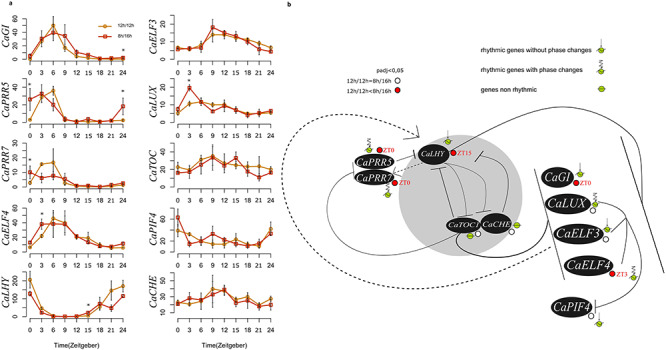
Photoperiod-dependent changes in the expression of core clock genes in 8 h/16 h and 12 h/12 h photoperiods. (a) Photoperiod responses of selected core clock genes. Orange line = 12 h/12 h, red line = 8 h/16 h. ZT0 is equivalent to ZT24. Overall, the patterns of expression observed are identical to those observed in Arabidopsis. Asterisks represent the significant differences of expression occurring between the two photoperiods. P-value was adjusted (Benjamini–Hochberg) and significance considered at a threshold of 0.05. Error bars are means ± SEM of three experimental replicates. (b) Expression of the circadian core clock genes and feedback regulations among them. Since we observe expression patterns similar to Arabidopisis ones, we used a figure adapted from Foo et al. (2016) and Singh and Mas (2018), and we made the hypothesis that Arabidopsis genes interactions are globally the same as in the coffee tree. Genes involved are represented in italic and they encode the following proteins: CaPRR5 = two-component response regulator-LIKE APRR5 (Cc02_g00820); CaLHY = protein LHY (Cc02_g39990); CaELF4 = protein ELF4-LIKE 4 (Cc04_g01390); CaLUX = LUX-ARRYTHMO (Cc06_g20160); CaTOC1 = two-component response regulator-like APRR1 (Cc04_g14990); CaPIF4 = putative transcription factor PIF4 (Cc05_g00300); CaPRR7 = two-component response regulator-like APRR7(Cc06_g03460); CaCHE = transcription factor TCP7 (Cc07_g19520); CaELF3 = protein EARLY FLOWERING 3(Cc08_g10110); CaGI = protein GIGANTEA (Cc10_g15270). Ca = C. arabica. The core clock circadian genes are in the shaded circle. Dashed arrows indicate gene induction and plain lines indicate a gene inhibition. The colored dots near the genes indicate if there is a difference of expression between the two photoperiods (12 h/12 h vs 8 h/16 h); red dots correspond to overexpressed genes at the photoperiod 8 h/16 h and white dots represent genes without difference of expression between the two photoperiods. When the difference of expression occurs between the two photoperiods, the time expressed in hours after the sunrise (ZT) is mentioned next to the dots. Analyses were done with P-value adjusted by Benjamini–Hochberg and with a threshold of 0.05.